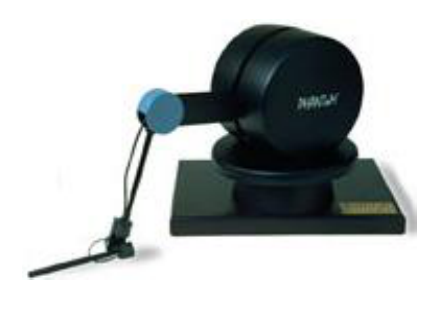
Figure 3. PHANToM